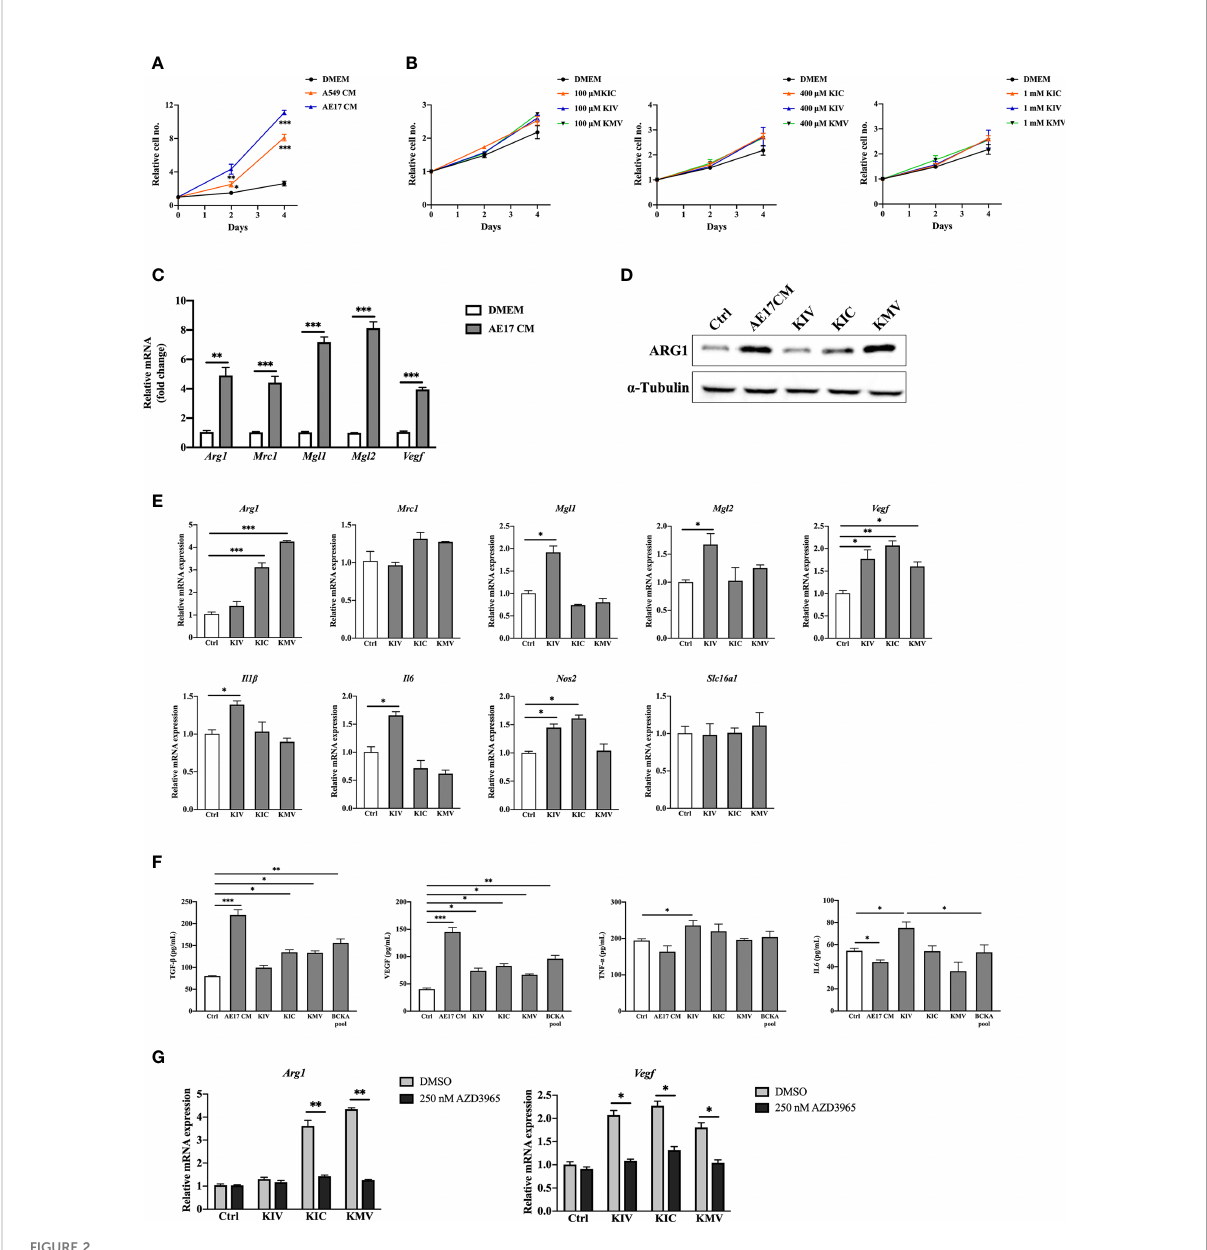
FIGURE 2 BCKAs in cancer cell CM induce murine BMDM polarization. (A) , Relative proliferation rate of BMDM grown in DMEM complete medium or indicated cancer cell CM. (B) , Relative proliferation rate of BMDM grown in DMEM complete media or equivalent media containing 200 m M KIV or 200 m M KIC or 200 m M KMV (n = 3). (C) , mRNA expression of Arg1 , Mrc1 , Mgl1 and Mgl2 in BMDM was measured by qPCR after incubation with AE17 CM for 24 hours. (D) , ARG1 protein level was measured by western blot after incubation with AE17 CM for 24 hours. (E) , mRNA expression of Arg1 , Mrc1 , Mgl1 , Mgl2 , Vegf , Il1 b , Il6 , Nos2 and Slc16a1 was measured in BMDM after stimulation with DMEM (Control), 200 m M KIV, 200 m M KIC and 200 m M KMV, respectively for 24 hours. (F) , Cytokines TGF- b , TNF- a , IL6 and growth factor VEGF in BMDMs after the indicated treatments were measured by ELISA kits. (G) , mRNA expression of Arg1 and Vegf was measured after pretreatment with the MCT1 inhibitor 250 nM AZD3965 for 1 hour, and stimulation with 200 m M KIV, 200 m M KIC and 200 m M KMV, respectively for 24 hours. Data show the mean ± SEM of n = 3 biological experiments. * p < 0.05, ** p < 0.01, *** p < 0.001 (unpaired two-tailed t